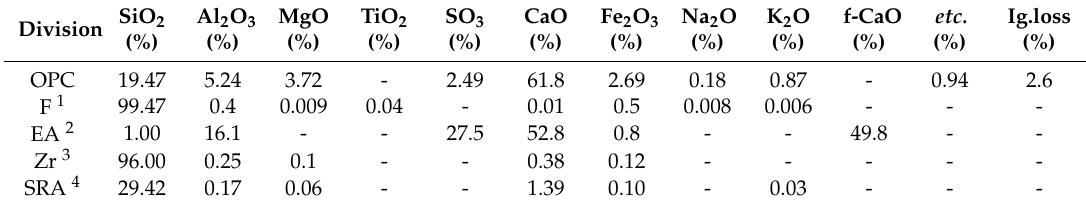
Table 3. Chemical composition of binder.